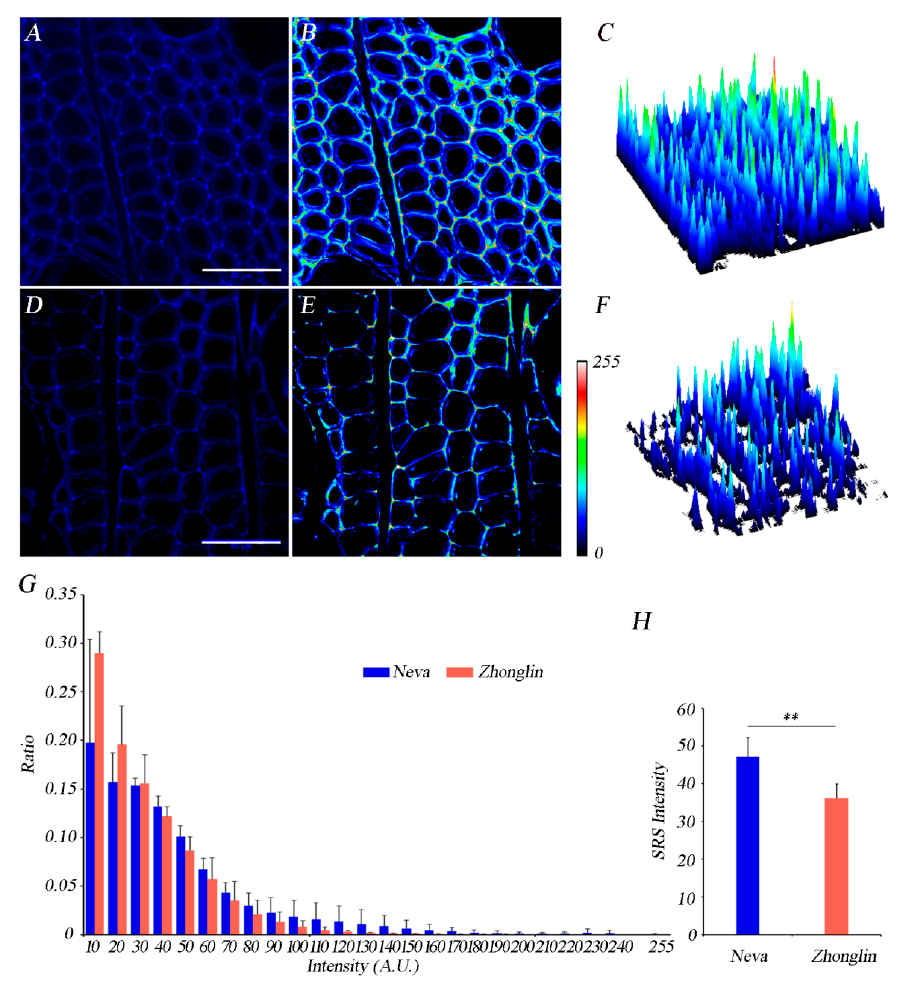
Figure 3. Quantification of lignin in mature xylem from two black poplar cultivars. ( A , D ) SRS images of P. euramericana ‘Neva’ ( A ) and P. euramericana ‘Zhonglin46’ ( D ) acquired at 1600 cm − 1 , showing the lignin distribution. Scale bar = 50 µ m. ( B , E ) Heat map of ( A ) and ( D ). ( C , F ) The 3D surface plots of ( A ) and ( D ). ( G ) Distribution of fluorescence intensity of the SRS images in ( A ) and ( D ). ( H ) The average intensity of lignin in xylem cells from the two black poplar cultivars. **, p < 0.01.